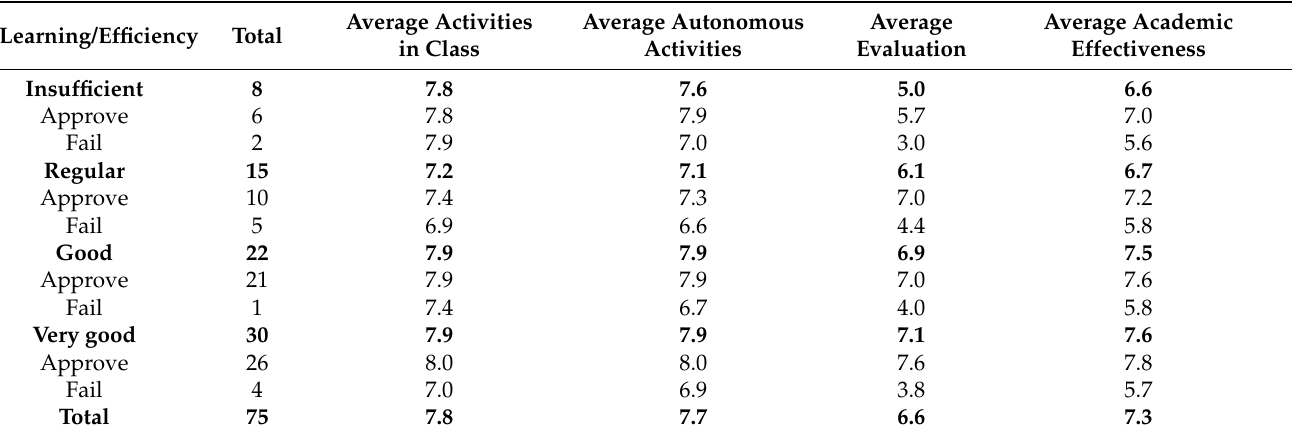
Table 17. Analysis of the data obtained from the 2022 period with the establishment of the categories of learning and academic effectiveness.